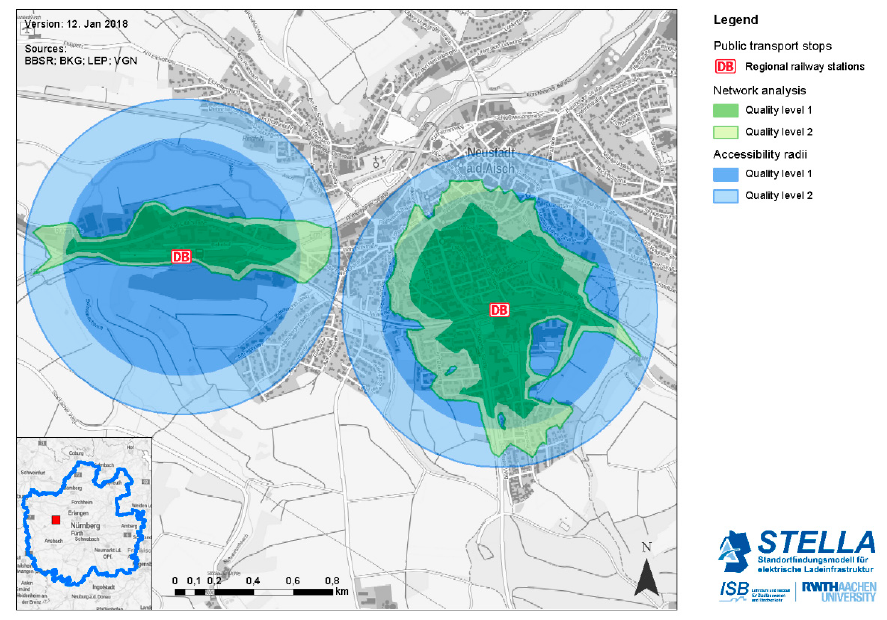
Figure 4. Schematic comparison of accessibility radii and network analysis (own depiction).